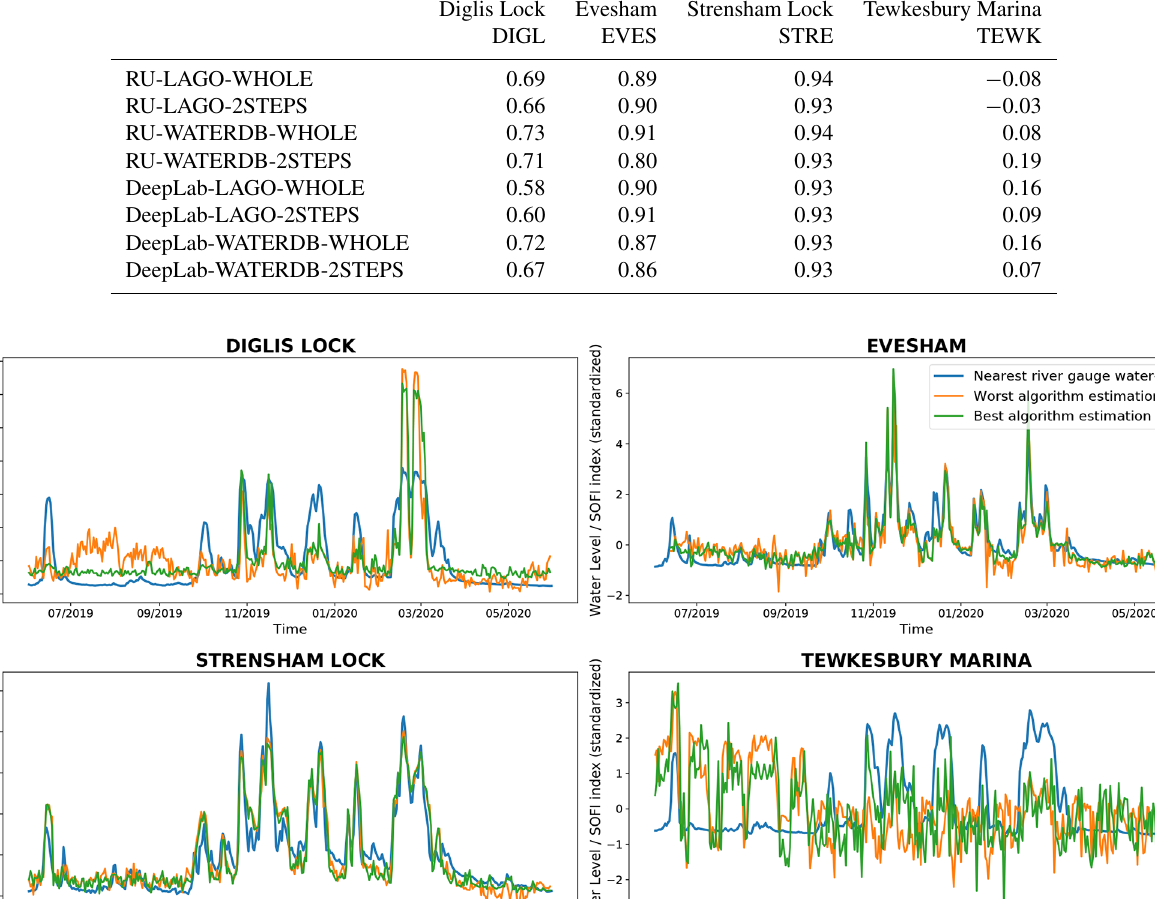
Table 6. Pearson’s correlation coefficients computed between the SOFI and the water levels obtained from the nearest river gauges. Diglis Lock